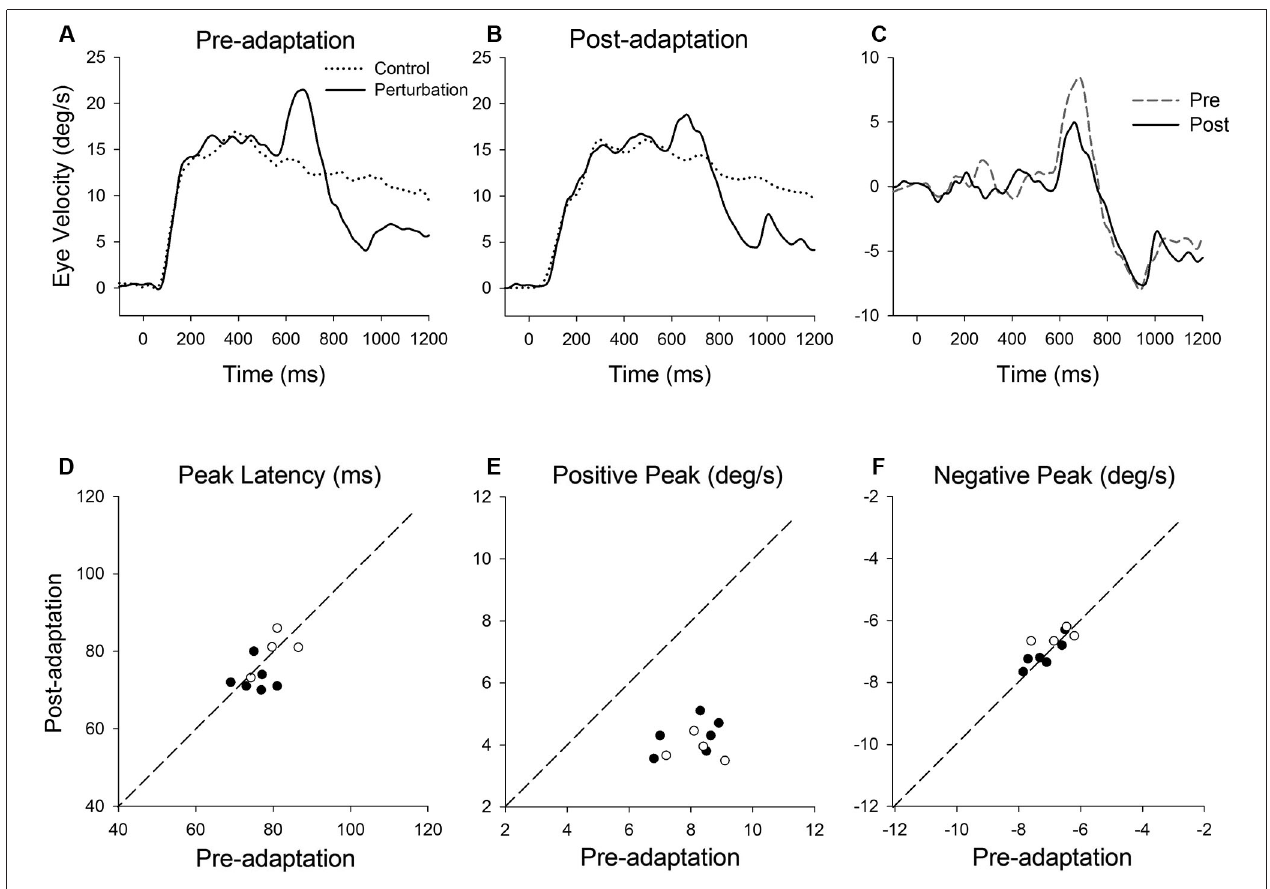
(solid line). (D) Mean values of perturbation latency, (E) positive peak velocity and (F) negative peak velocity are shown pre- and post-adaptation. Open and filled symbols indicate monkey-P and B,